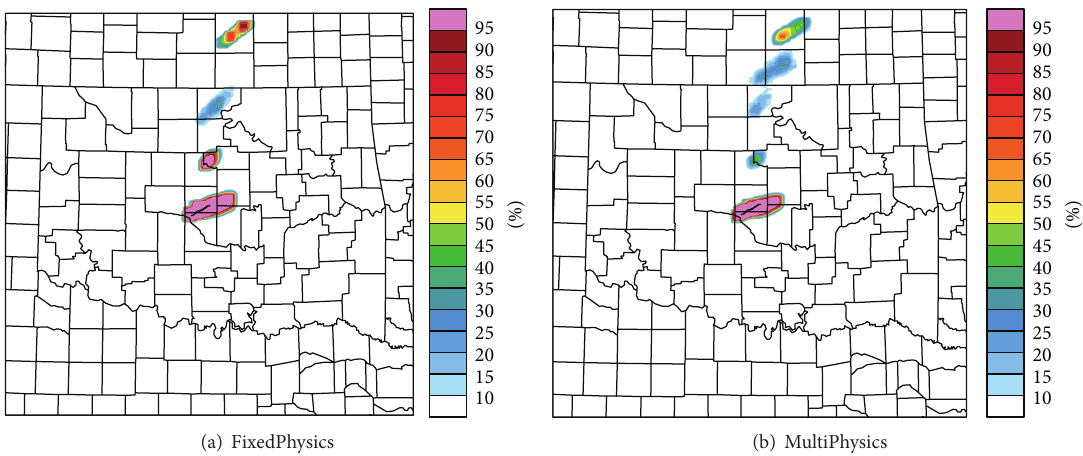
Figure 6: Neighborhood ensemble probability forecasts of 0–3 km updraft helicity from (a) FixedPhysics and (b) MultiPhysics convective- scale ensembles exceeding thresholds of 50 m 2 s −2 starting at 2200 UTC and ending at 2240 UTC over the entire convective-scale domain. Overlaid in each panel is the NWS observed tornado damage track (black outline) that starts at 2210 UTC and ends at 2238